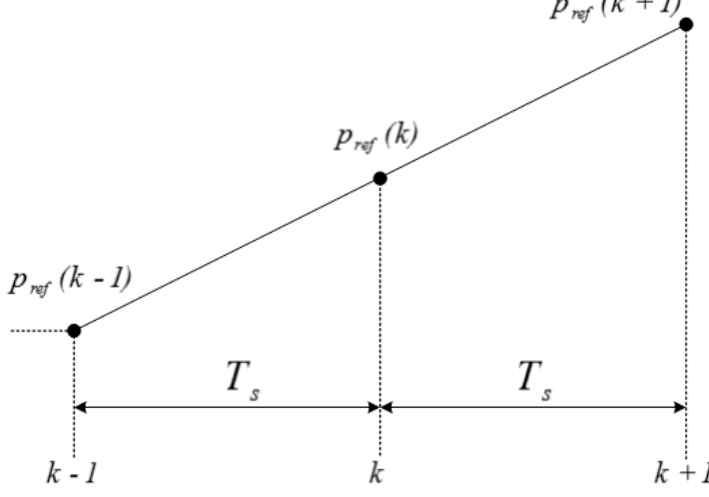
Figure 3. Predictive value estimation of reference active power.